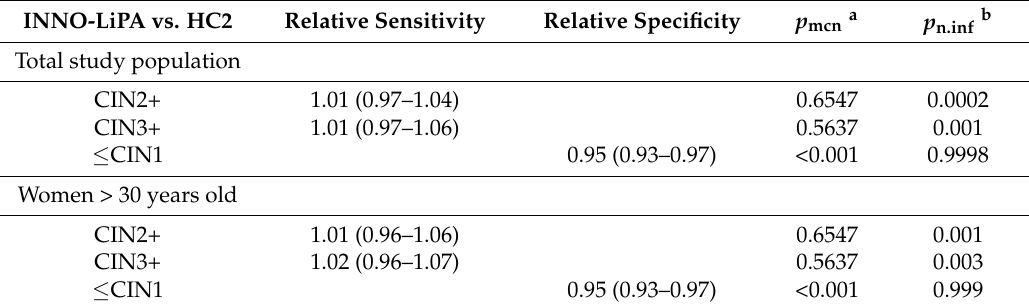
Table 3. Relative sensitivities for detection of CIN2+ and CIN3+ and relative specificity for detection of ≤ CIN1 of INNO-LiPA versus HC2. Analysis was performed separately for the total study population and for women ≥ 30 years